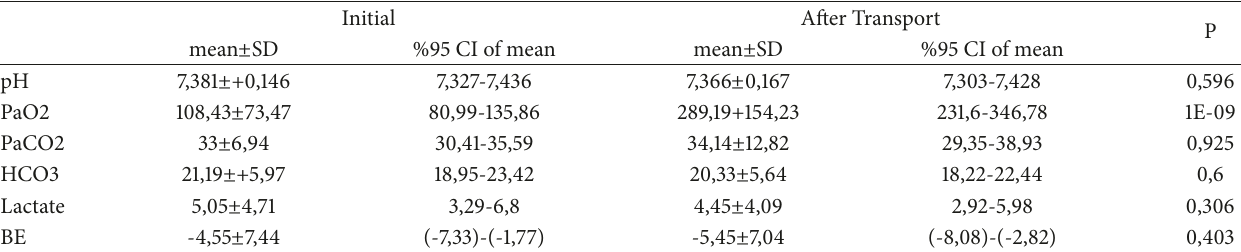
Table 3: Blood gas analysis of type 1 respiratory failure patients.